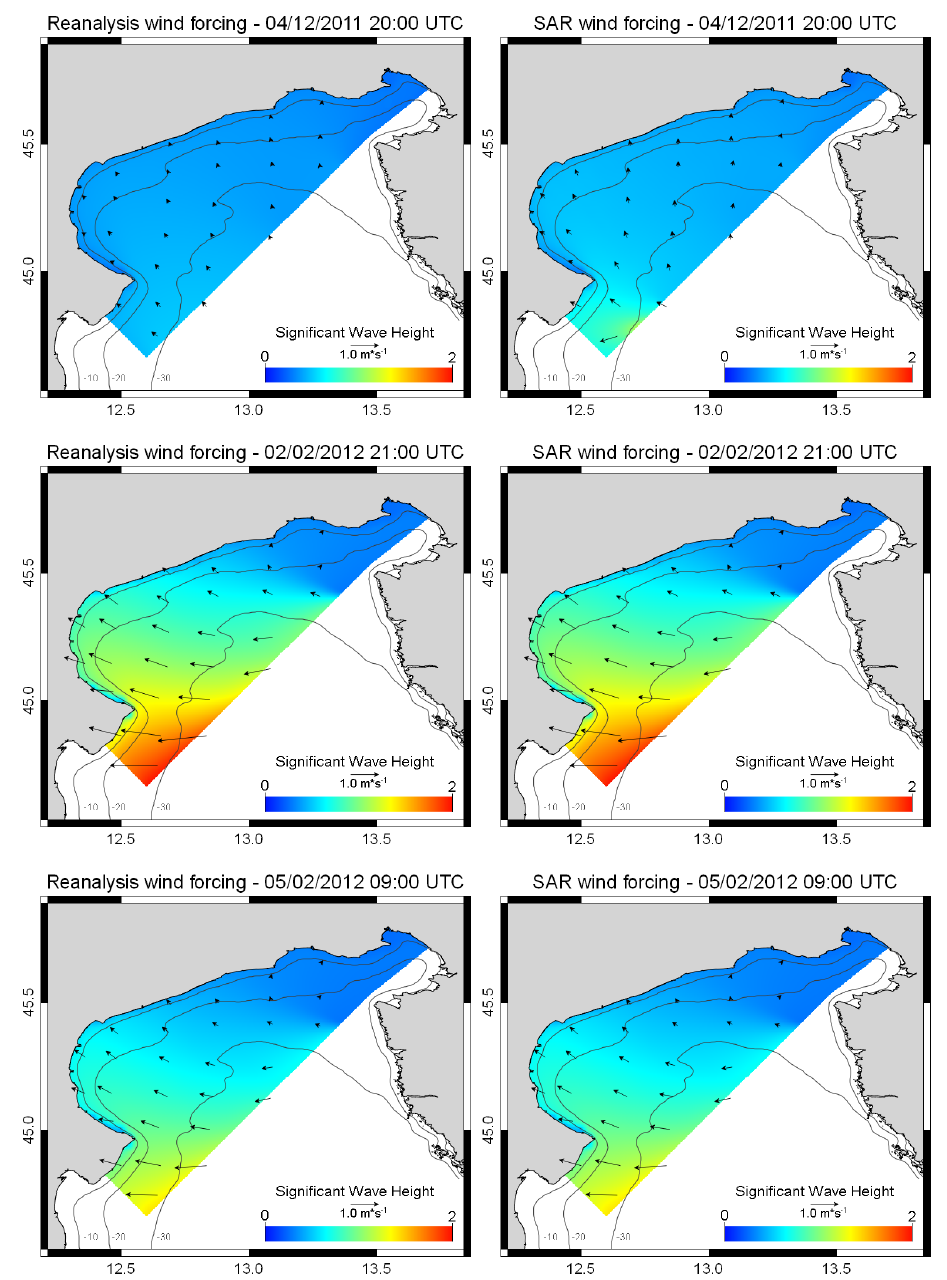
Figure 6. Some cases of wave fields forced with reanalysis winds (left) and SAR winds (right). Solid isolines are the bathymetric contour